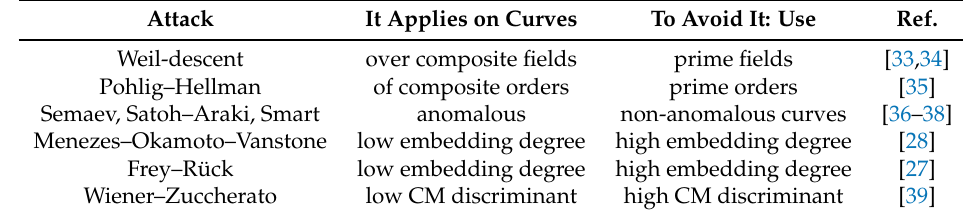
Table 1. Attacks on ECDLP over special curves